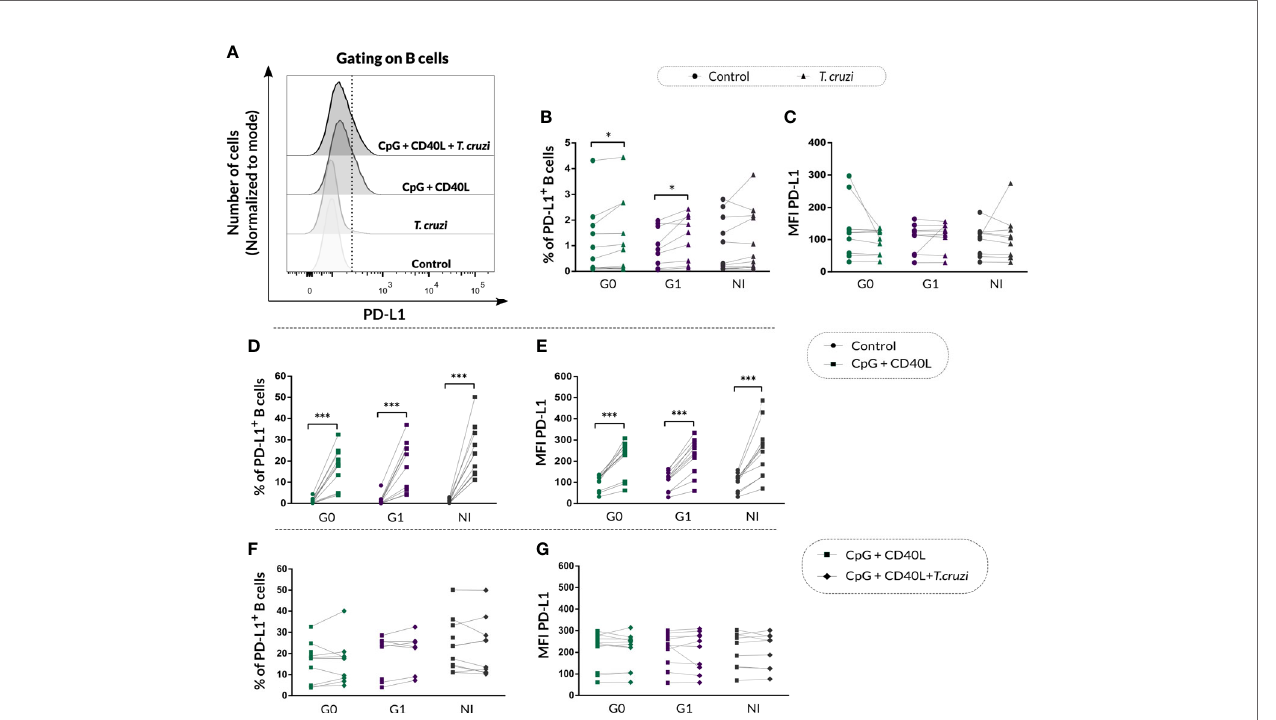
FIGURE 7 | PD-L1 expression on isolated B cells from patients with CCD and NI donors following T. cruzi or CpG + CD40L stimulation. (A) Fluorescence histograms showing PD-L1 expression in T. cruzi , CpG + CD40L, or CpG + CD40L + T. cruzi – stimulated or Control B cells. Data from one NI donor are illustrated. Dotted line shows the cut point to identify PD-L1 + B cells (CD19 + PD-L1 + ). (B, C) Frequency of PD-L1 + B cells and MFI for PD-L1 on Control or T. cruzi – stimulated B cells from CCD patients (G0, G1) and NI donors. (D, E) Frequency of PD-L1 + B cells and MFI for PD-L1 on Control or CpG + CD40L – stimulated B cells from CCD patients (G0, G1) and NI donors. (F, G) Frequency of PD-L1 + B cells and MFI for PD-L1 on CpG + CD40L or CpG + CD40L + T. cruzi – stimulated B cells from CCD patients (G0, G1) and NI donors. Each symbol represents data from one individual. Statistically signi fi cant differences are indicated with asterisks (*) p < 0.05, (***) p <